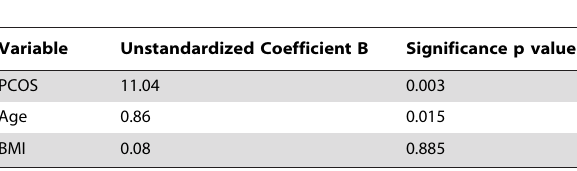
Table 3. Age and BMI independent effects of PCOS on central arterial stiffness, as measured by augmentation